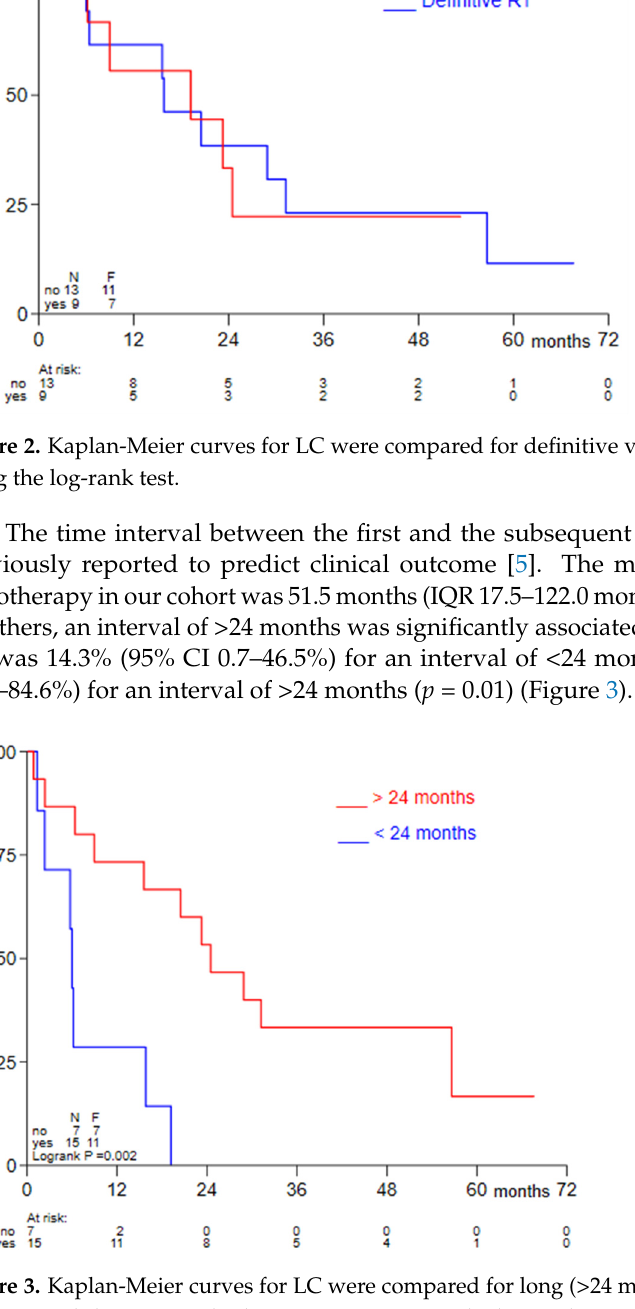
Figure 3. Kaplan-Meier curves for LC were compared for long (>24 months) and short (<24 months) time intervals between radiotherapy courses using the log-rank test.